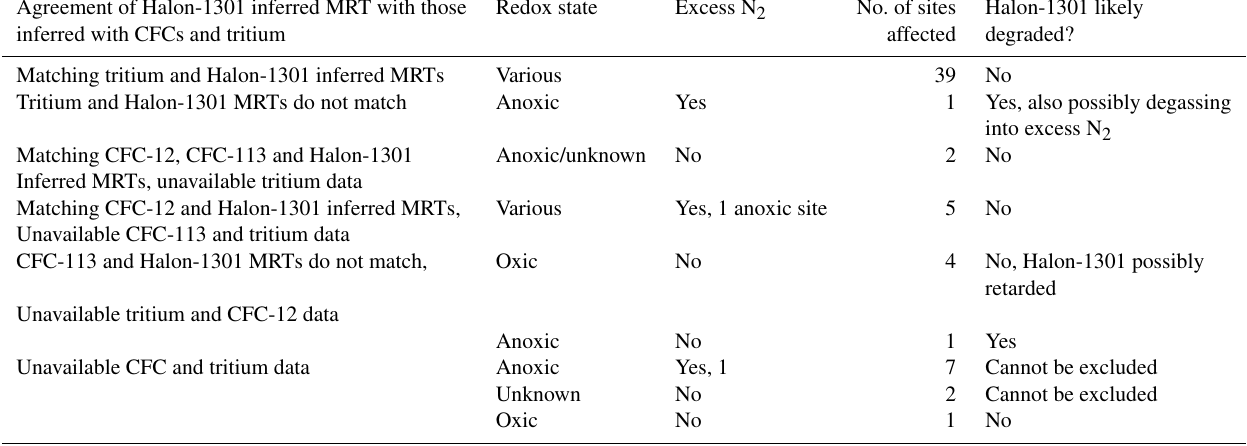
Table 4. Breakdown of 62 sites that indicated elevated MRTs inferred with Halon-1301 compared to those inferred with SF 6 , and assessment of possibility that the differences in SF6 and Halon-1301 inferred MRTs have been caused by degradation of Halon-1301 in groundwater. Agreement of Halon-1301 inferred MRT with those Redox state Excess N 2 No. of sites Halon-1301 likely inferred with CFCs and tritium affected degraded? Matching tritium and Halon-1301 inferred MRTs Various